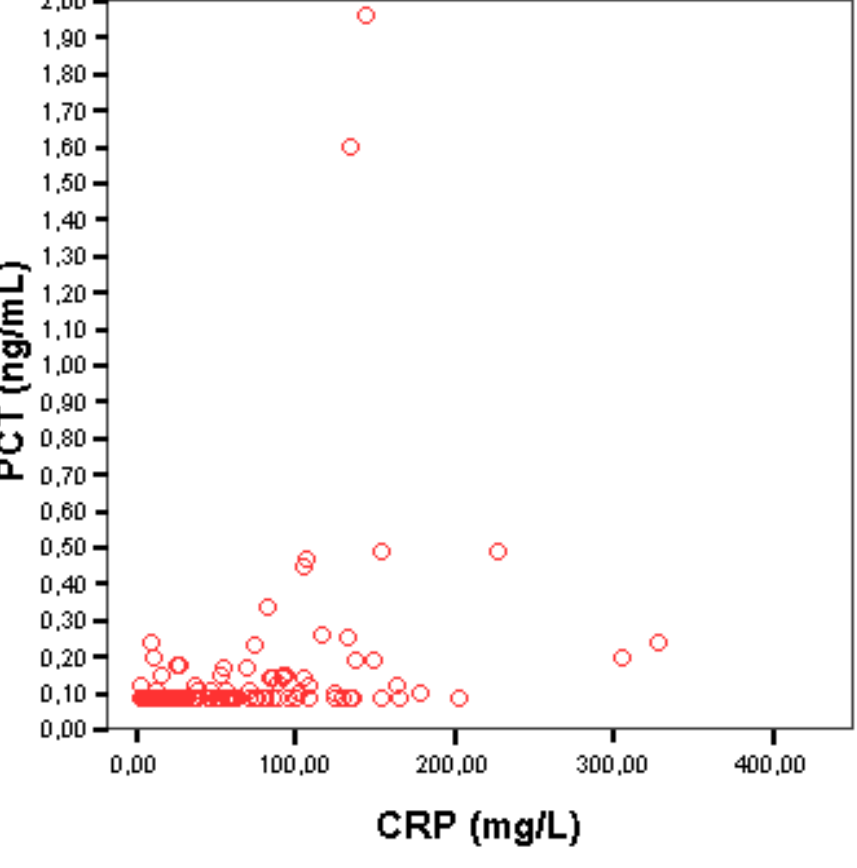
Figure 1. Correlation between serum PCT and CRP. Table 2. Demographic, clinical and laboratory findings, including inflammatory markers according to PCT concentration in patients with